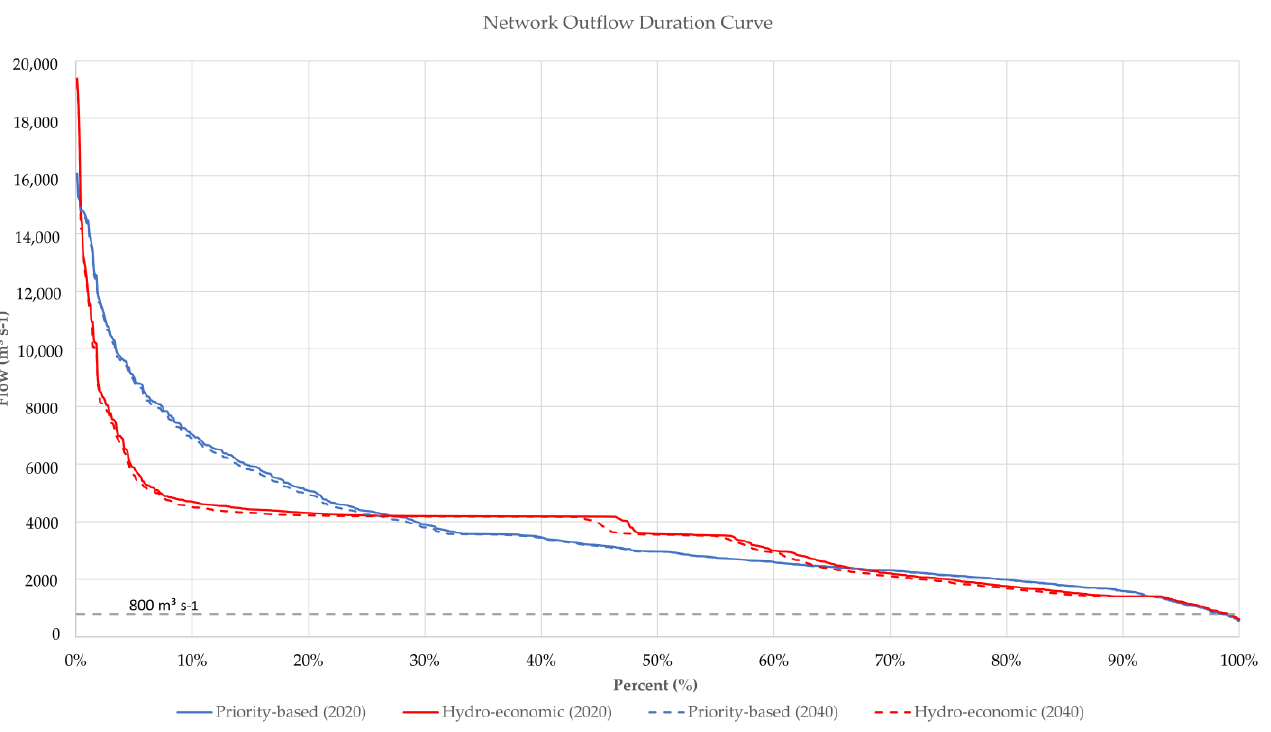
Figure 8. Flow duration curve at the outflow node.